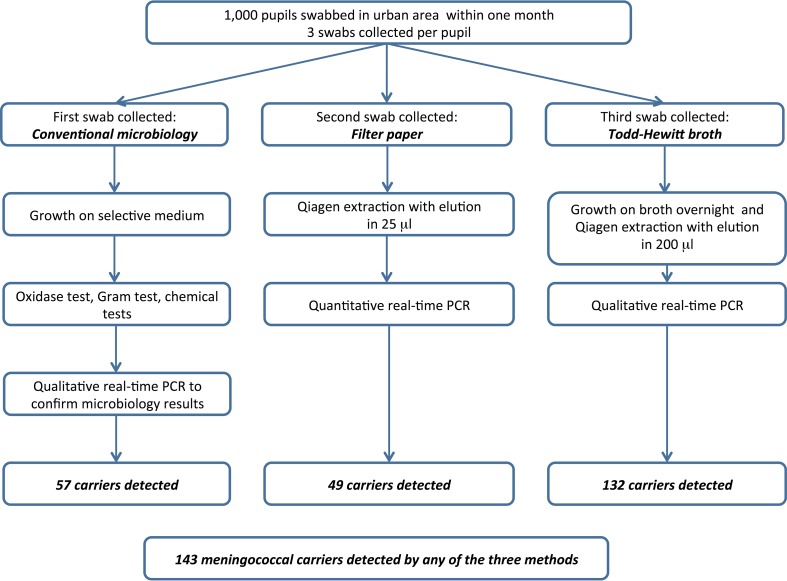
Summary of the methodology employed in the study.